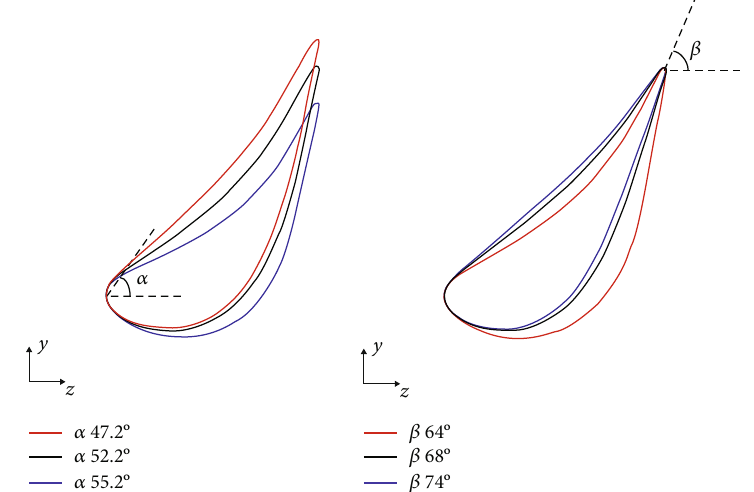
Figure 1: Parameters de fi